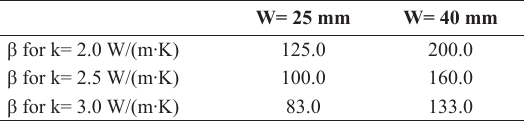
Table 5. Biot modulus estimative for materials A2 and A8.